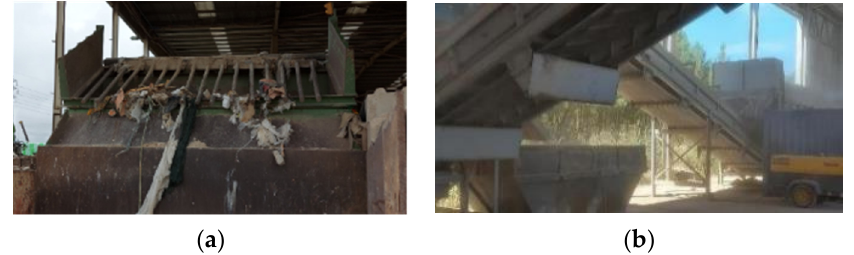
Figure 2. Initial sieving at the feeder ( a ) Removal of large and elongated materials with bar sieve ( b ) Removal of finer